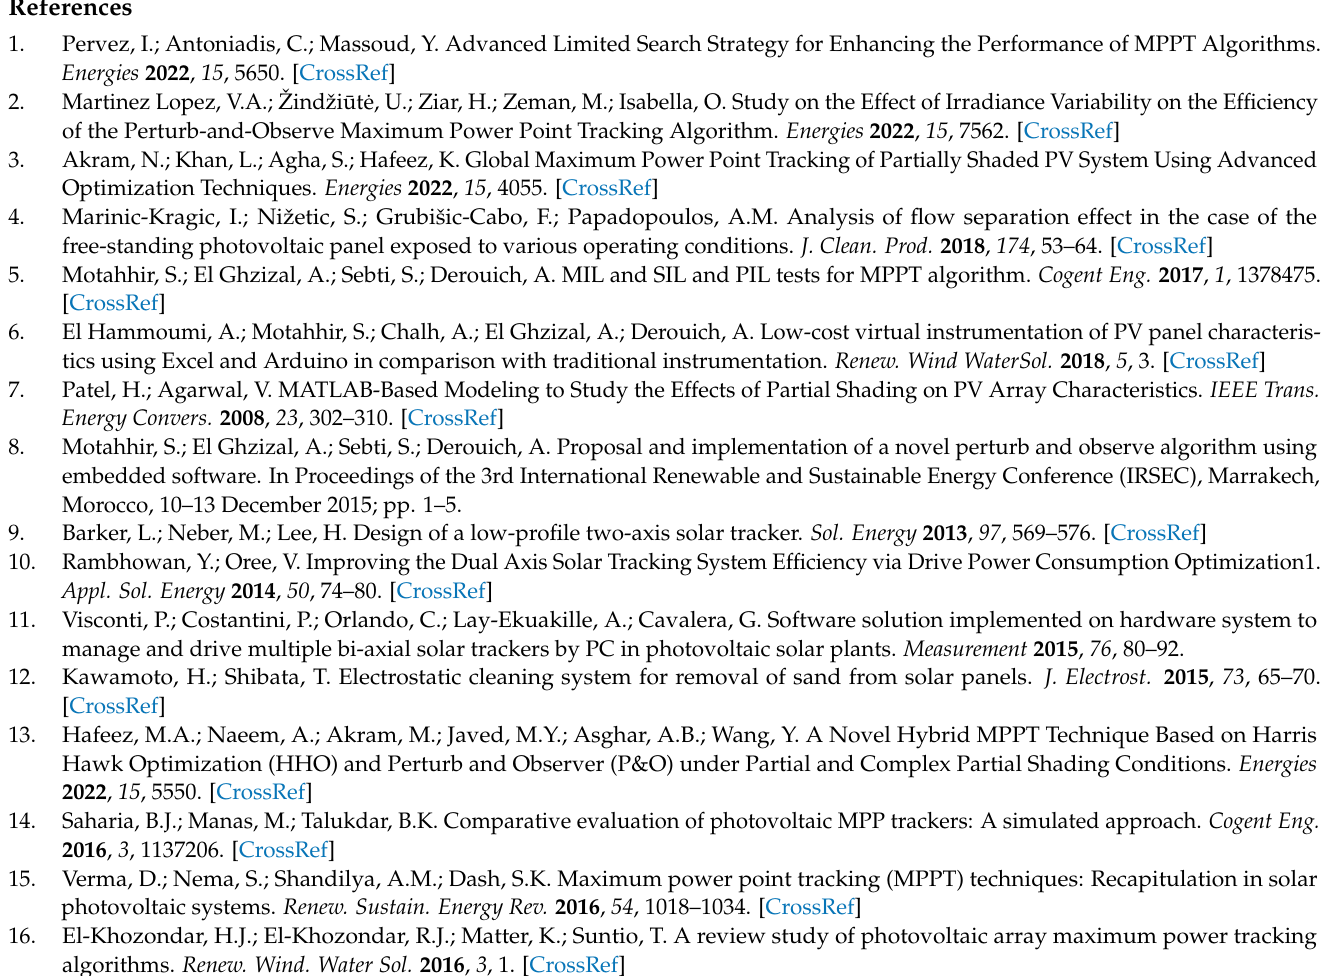
Figure S3: Datasheet of the PV module used in the hardware